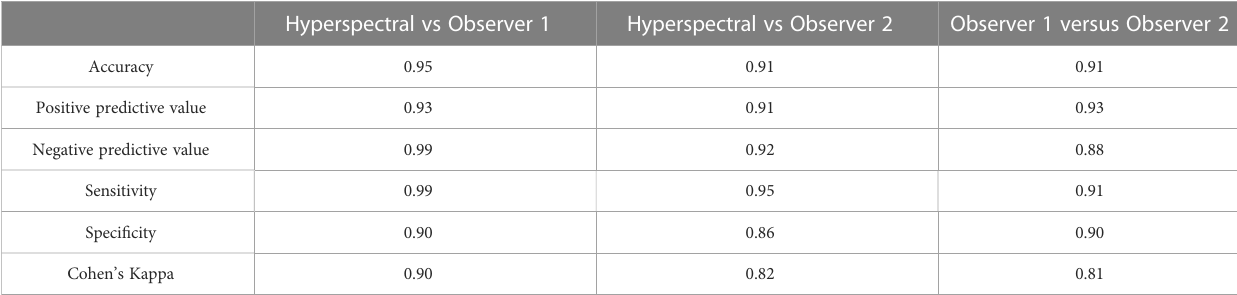
TABLE 4 Measures of performance in classifying active versus healed or undamaged dorsal fi ns using hyperspectral imaging as compared to two human observers.